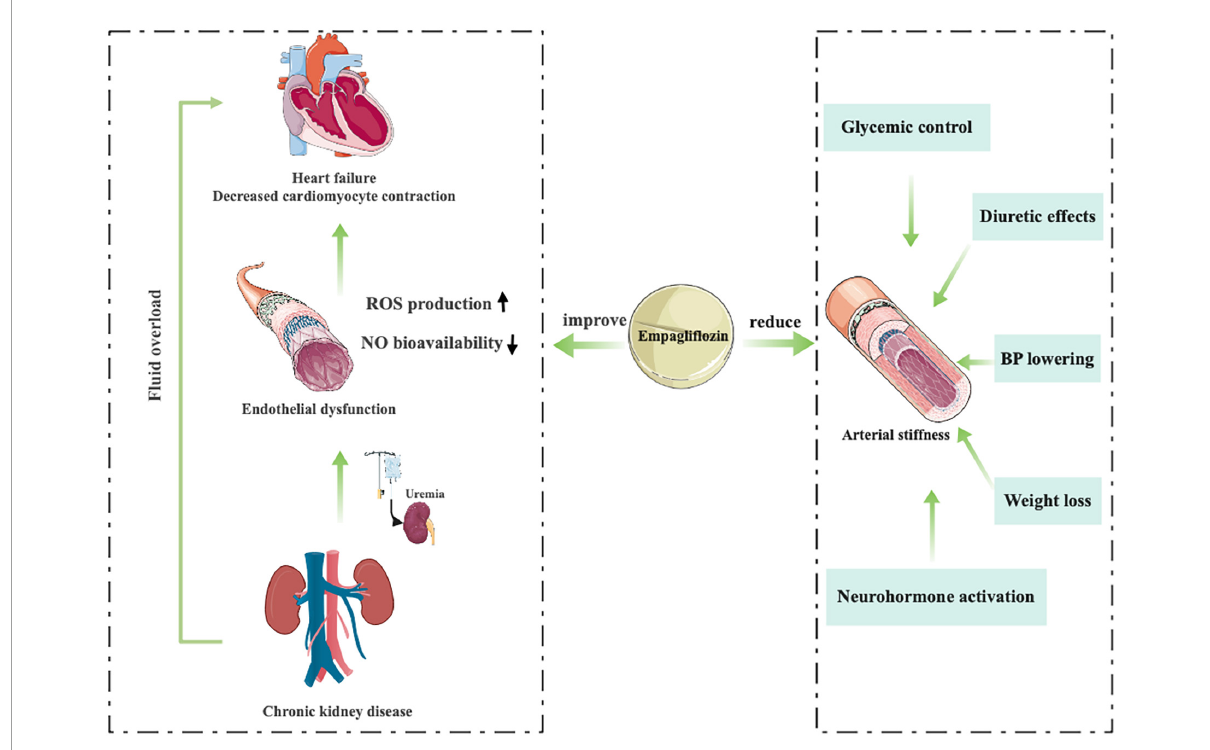
FIGURE6 Empagliflozin improves endothelial function and reduces arterial